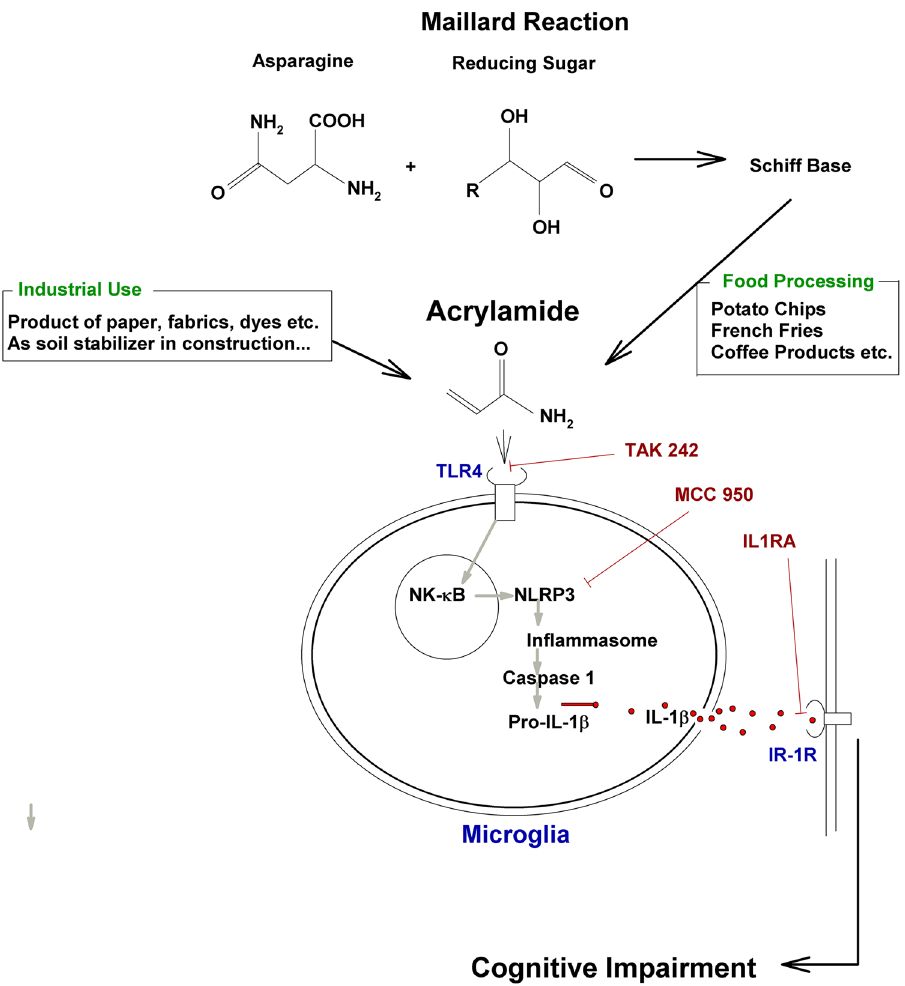
Figure 7. Schematic diagram to show how humans are exposed to ACR and a possible mechanism how ACR impairs cognitive function via activation of TLR4 and the NLRP3 inflammasome in microglia. Brown lines show locations where inhibitors